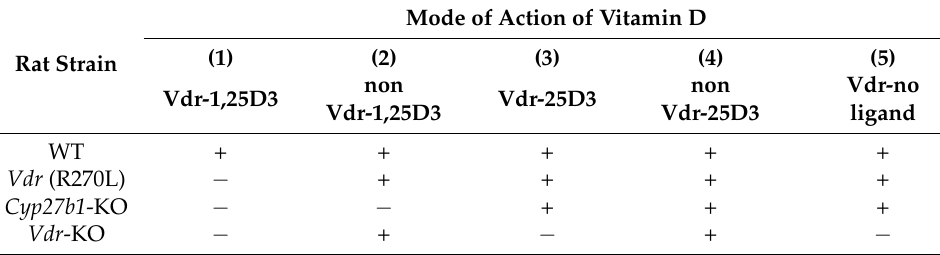
Table 1. Vitamin D and/or VDR actions observed in WT and GM rats